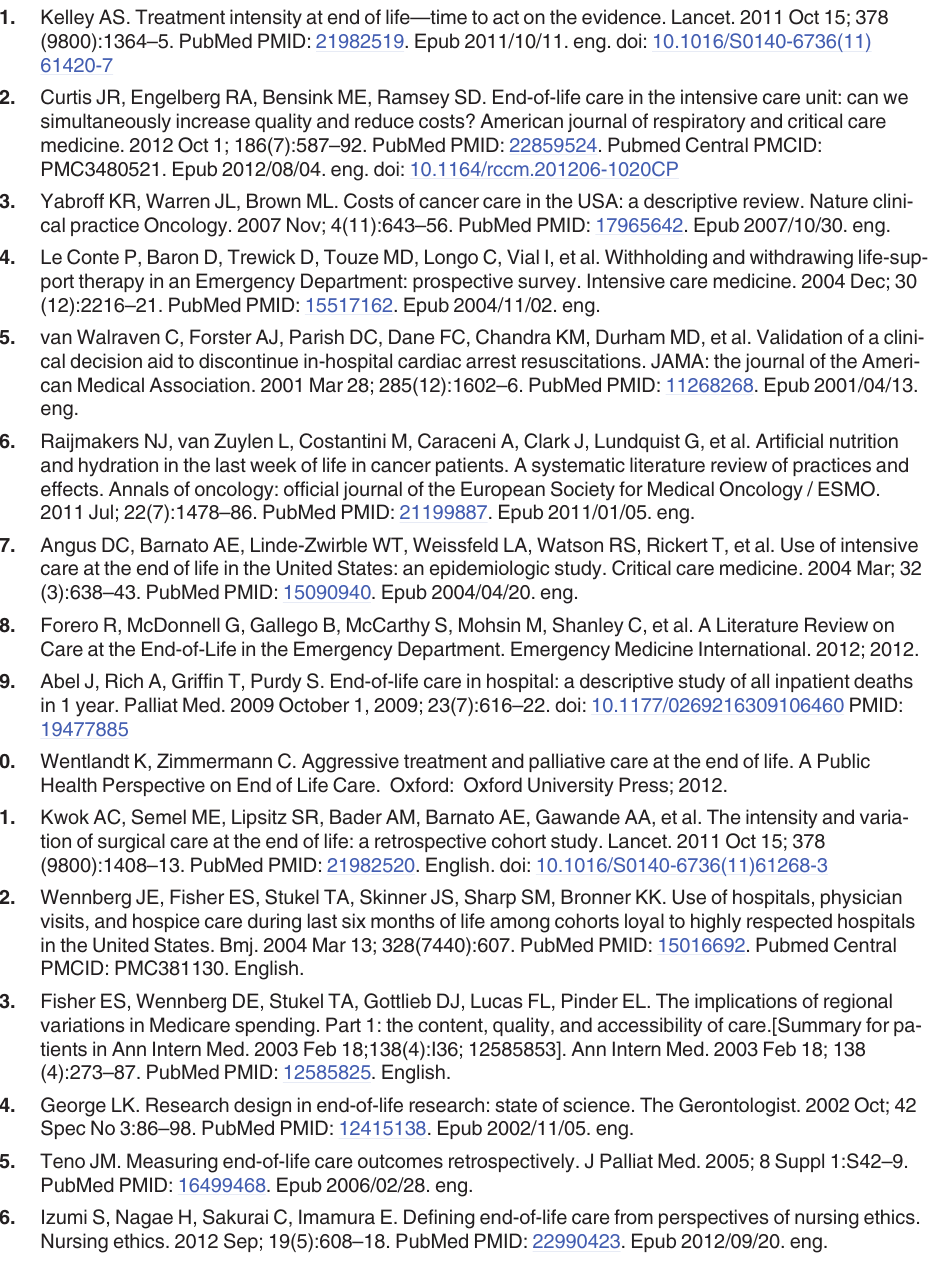
S2 Table. Summary table of excluded